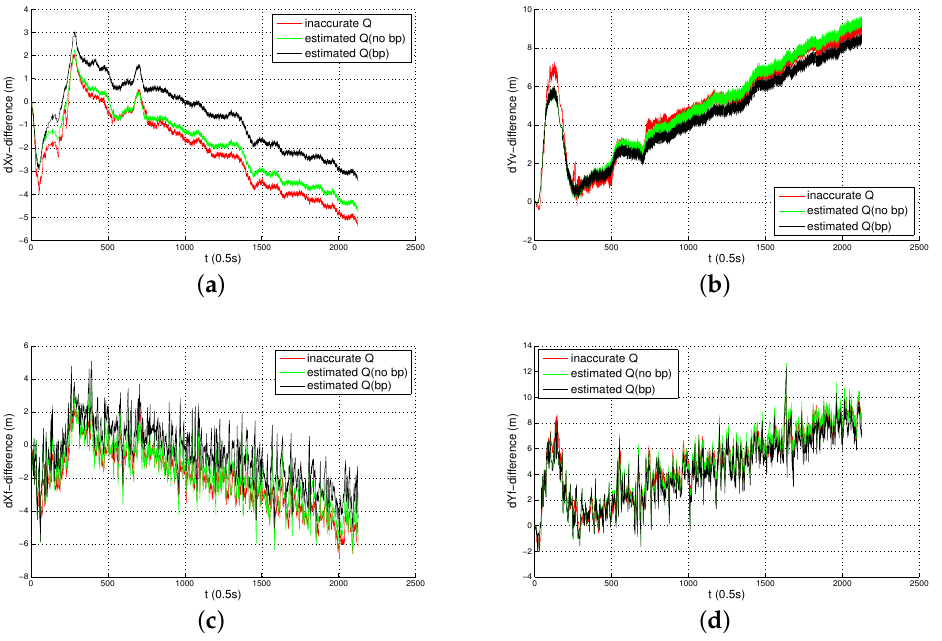
Figure 13. The positioning error of AUV and MRS, in which ( a ) illustrates the horizontal direction of the positioning error components of AUV in global frame; ( b ) illustrates the vertical direction of the positioning error components of AUV in global frame; ( c ) illustrates the horizontal direction of the positioning error components of MRS in global frame; ( d ) illustrates the vertical direction of the positioning error components of MRS in global frame.